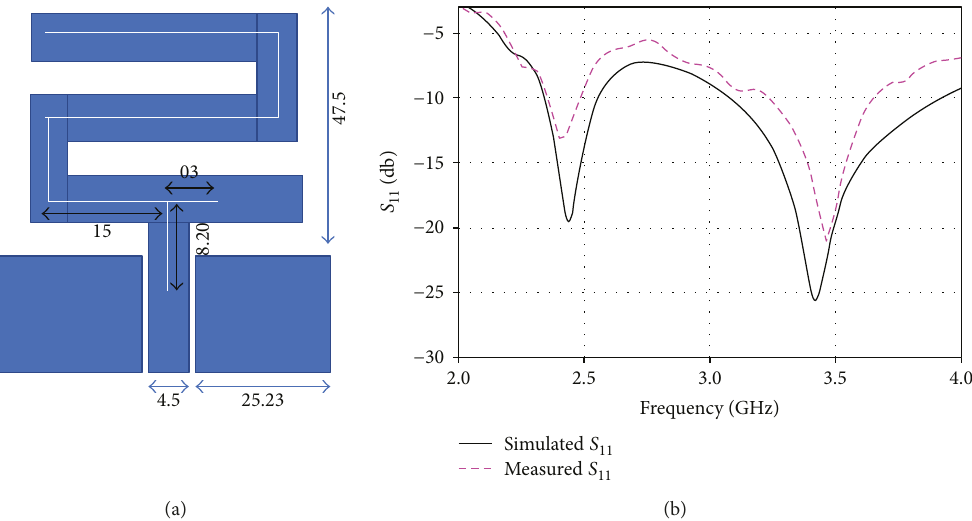
Figure 10: (a) The layout of the slotted Z-shaped antenna. (b) The re fl ection coe ffi cient S